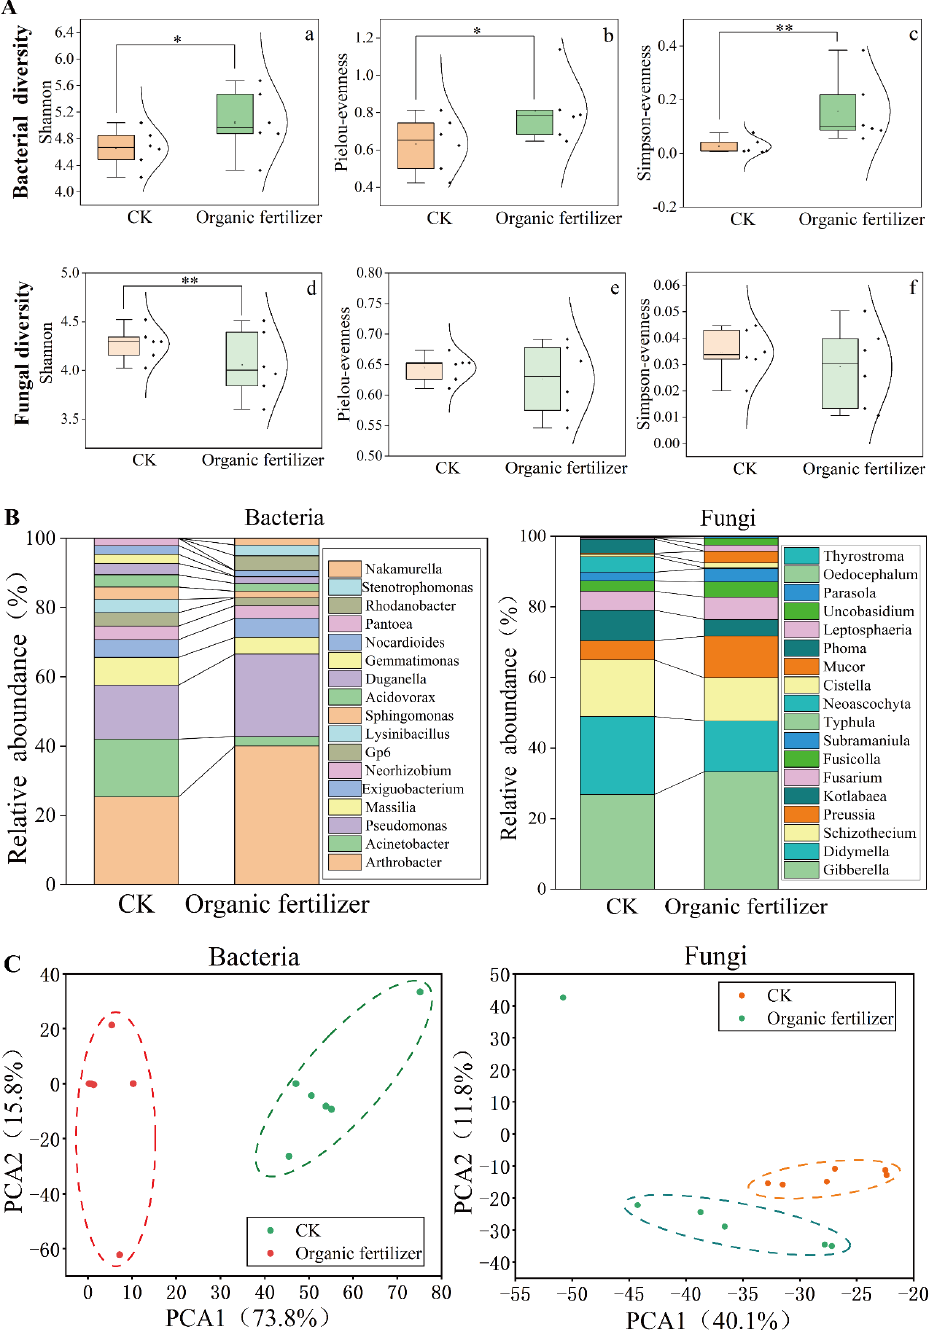
Figure 3. The diversity, structure, and composition of rhizosphere microbial communities in CK and organic fertilizer: ( A ) rhizosphere microbial community diversity and t -test (* p < 0.05, ** p < 0.01); ( B ) relative abundances of the dominant phyla in CK and organic fertilizer; ( C ) principal component analysis (PCA) of the prokaryotic community and the fungal